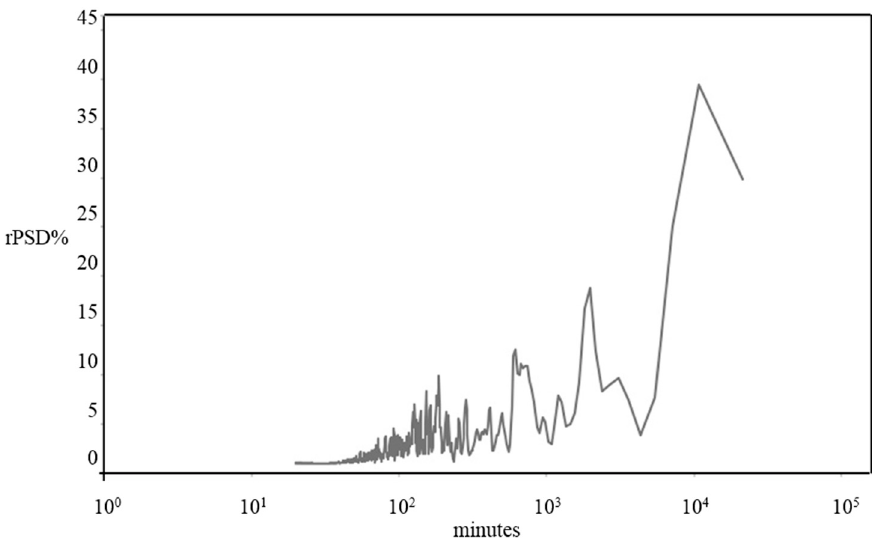
Figure 7. Example of spectral analysis by FT (Fourier Transform). Power values are shown on the y -axis; periods (in minute) on a logarithmic scale are shown on the x -axis.